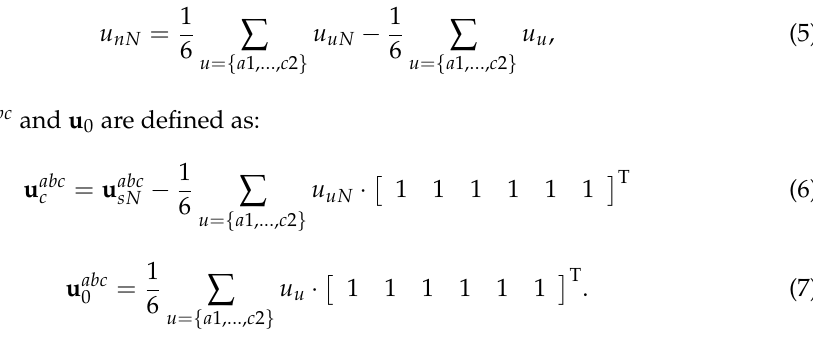
corresponds to the component of the PMSM voltages imposed by the 2L-VSIs, while vector u abc corresponds to the PMSM zero-sequence voltage components 0 (ZSVCs). Considering the 2 6 = 64 possibilities for vector s in (1) and (6), the 2L-VSIs can apply forty-nine distinct voltage vectors to the PMSM, whose mapping in the α - β , x - y and z 1- z 2 subspaces is shown in Figure 2.